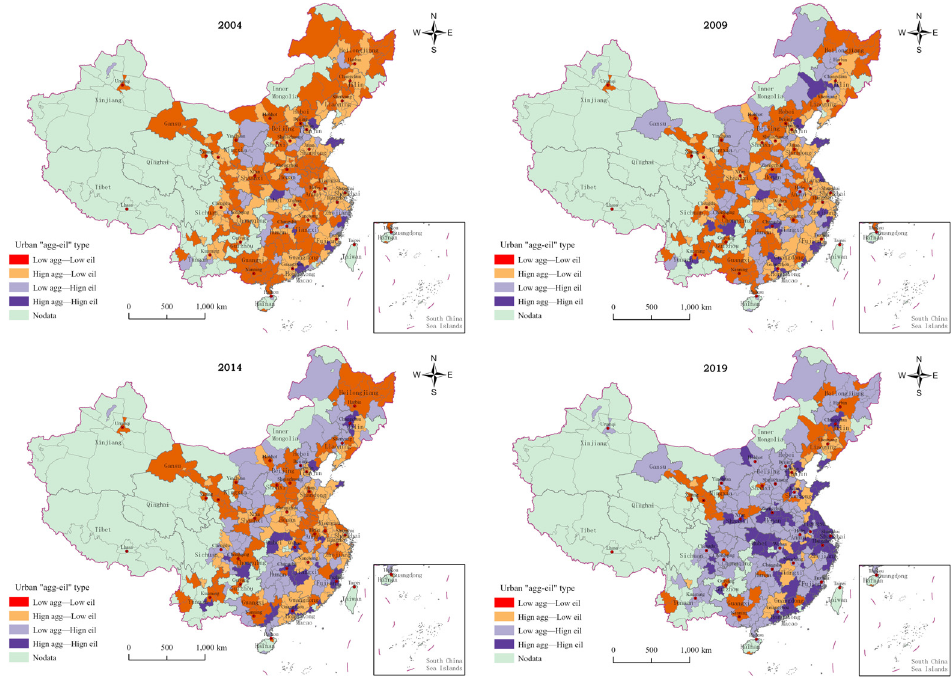
Figure 6. Classification of “agg-eil” types of Chinese cities from 2004–2019.